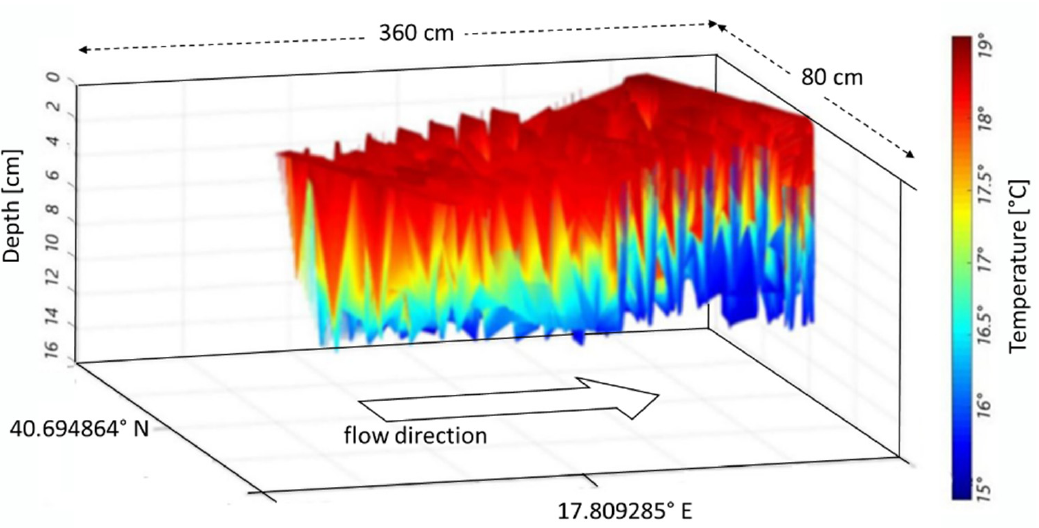
Figure 10. Temperature values retrieved by means of beamforming-based technique vs. depth and GPS references for cross-section B1.